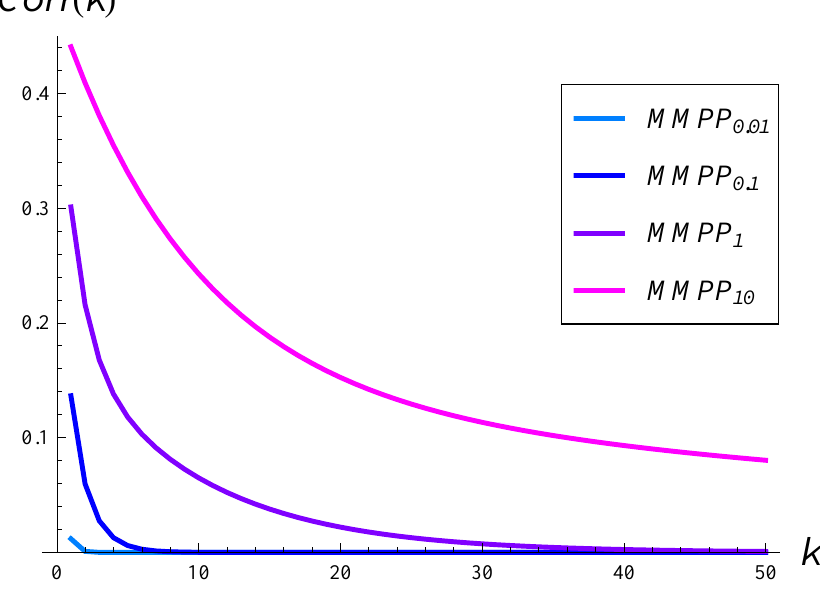
Figure 1. Autocorrelation of interarrival times vs. lag for different values of parameter q